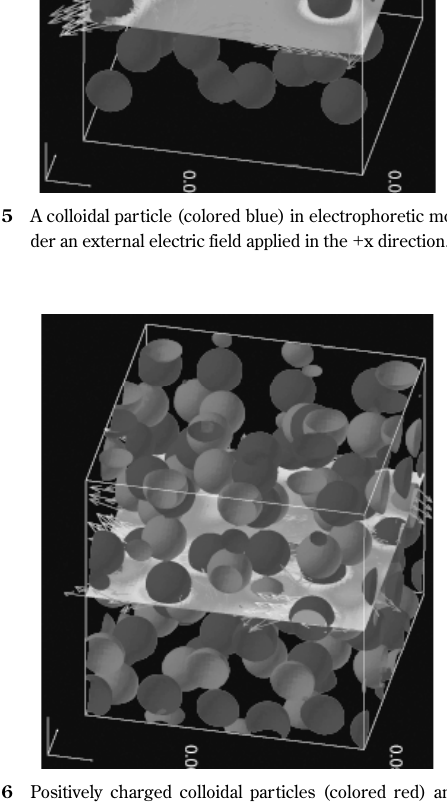
Fig. 6 Positively charged colloidal particles (colored red) and nega- tively charged colloidal particles (colored blue) in electropho- retic motion under an external electric field applied in the + x direction; positive-signed colloids migrate in the + x direction and negative-signed ones in the -x direction.